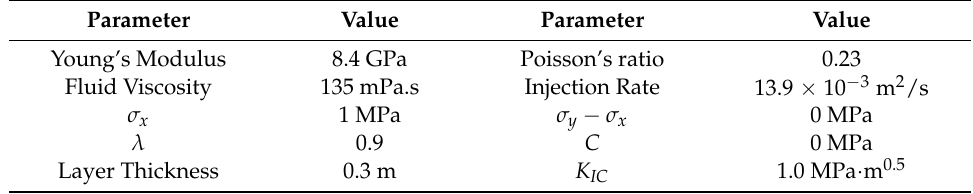
Figure 2. Fracture network configurations under different stress conditions. ( a ) The numerical setting and the pre-existing fracture network of case 1; ( b ) The numerical result of case 1; ( c ) The experiment result of case 1; ( d ) The pre-existing fracture network of case 2; ( e ) The numerical result of case 2; ( f ) The experiment result of case 2. The pre-existing fracture networks and the experiment results are obtained from Zhou et al. [16]. For numerical results, the fluid pressure ( p f ) is represented by color. The fractures that are not affected by fluid are represented by the gray meshes. The shear fractures are marked by the bold curves at the top. For experiment results, the stimulated fractures are marked by the bold red curves. Table 1. Default input parameters for the simulations in this paper. Here, σ x and σ y are the principle stresses along the x and y -axis directions respectively, λ is the friction coefficient between fracture surfaces, C is the cohesion of pre-existing fractures, layer thickness is the height of the model perpendicular to the modeling plain, and K IC is tensile mode fracture